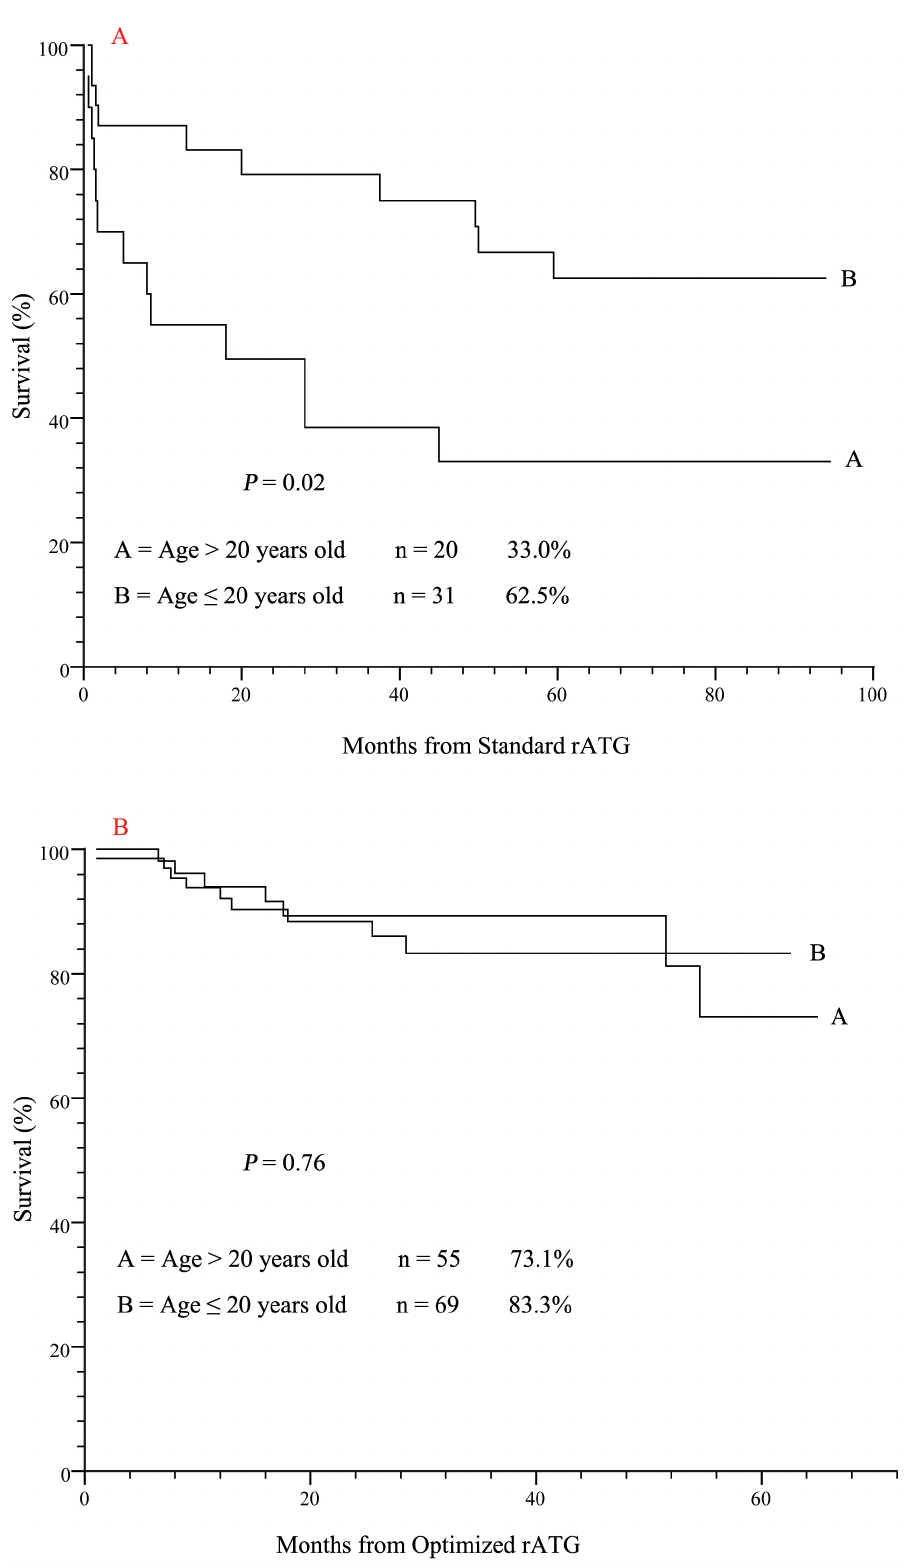
Figure 3. Different OS between younger ( ! 20 years) and older ( . 20 years) patients stratified by Standard rATG and Opitimized rATG. A, Following Standard rATG, older patients had a worse OS than younger ones ( P =0.02). B, Following Optimized rATG, older and younger patients had a similar OS.